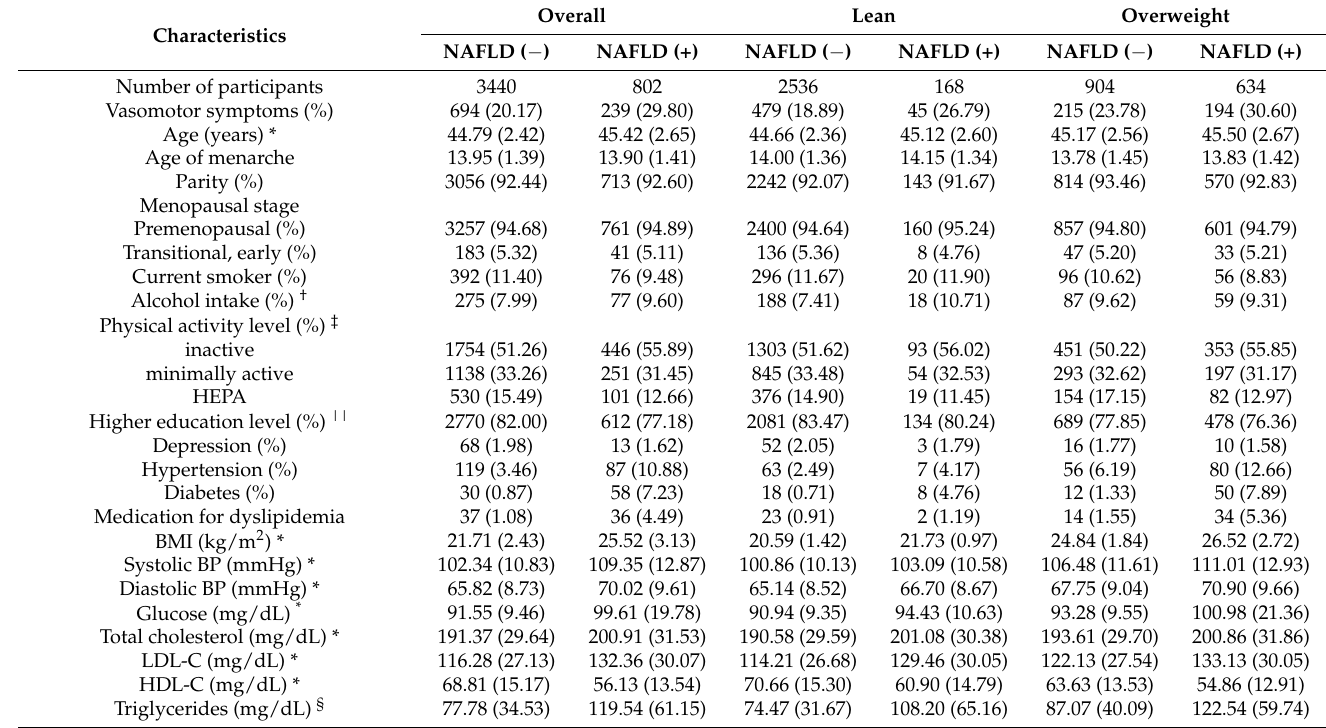
Table 1. Baseline characteristics of study participants ( n = 4242).